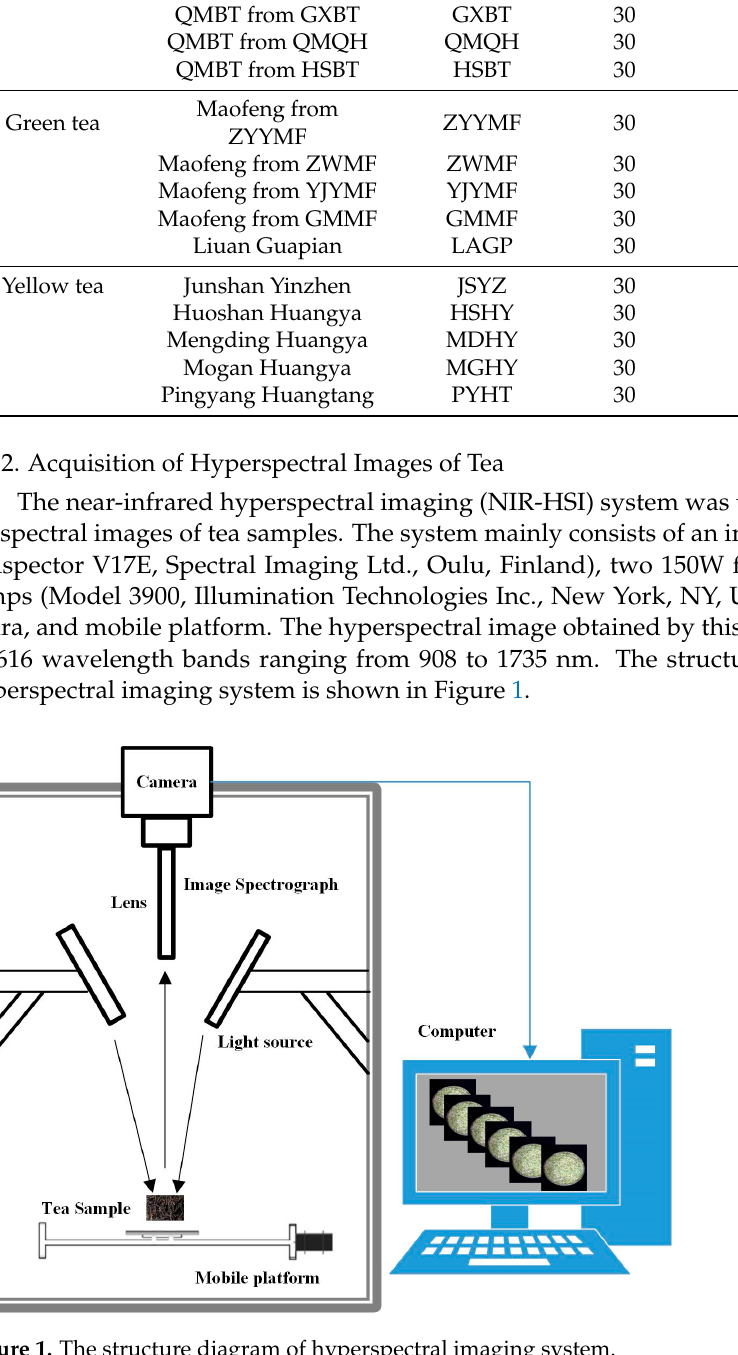
Figure 1. The structure diagram of hyperspectral imaging system.